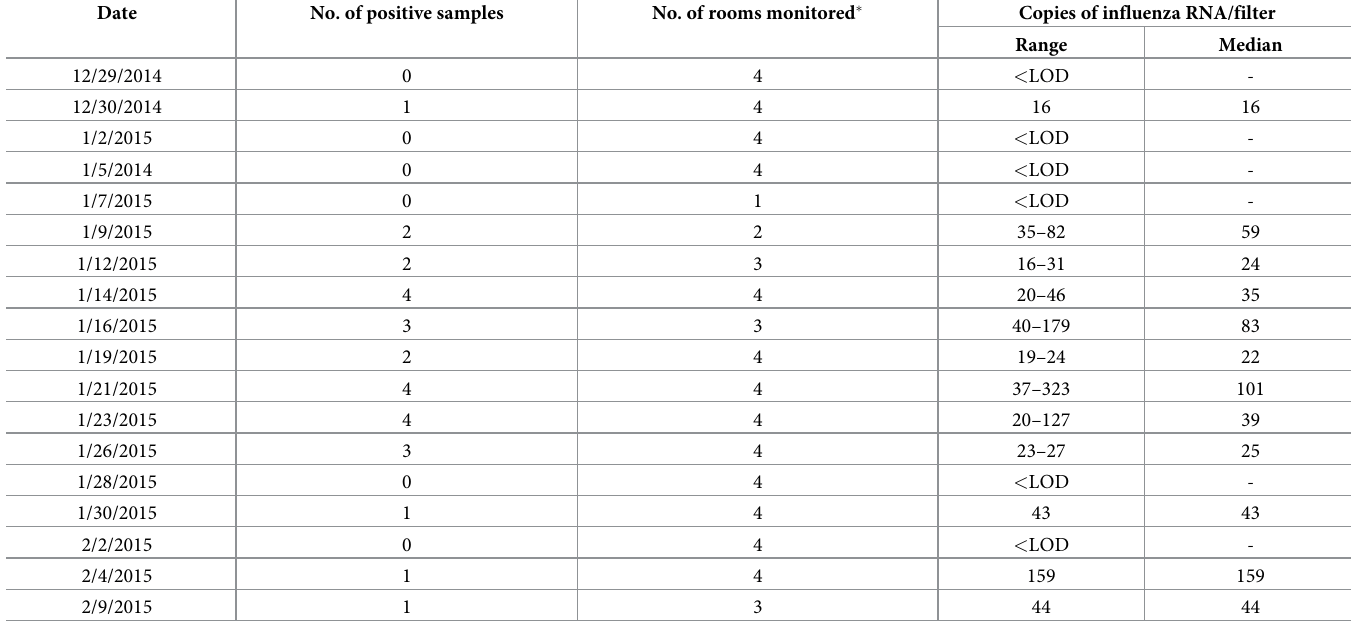
Table 2. Room bioaerosol sample results by